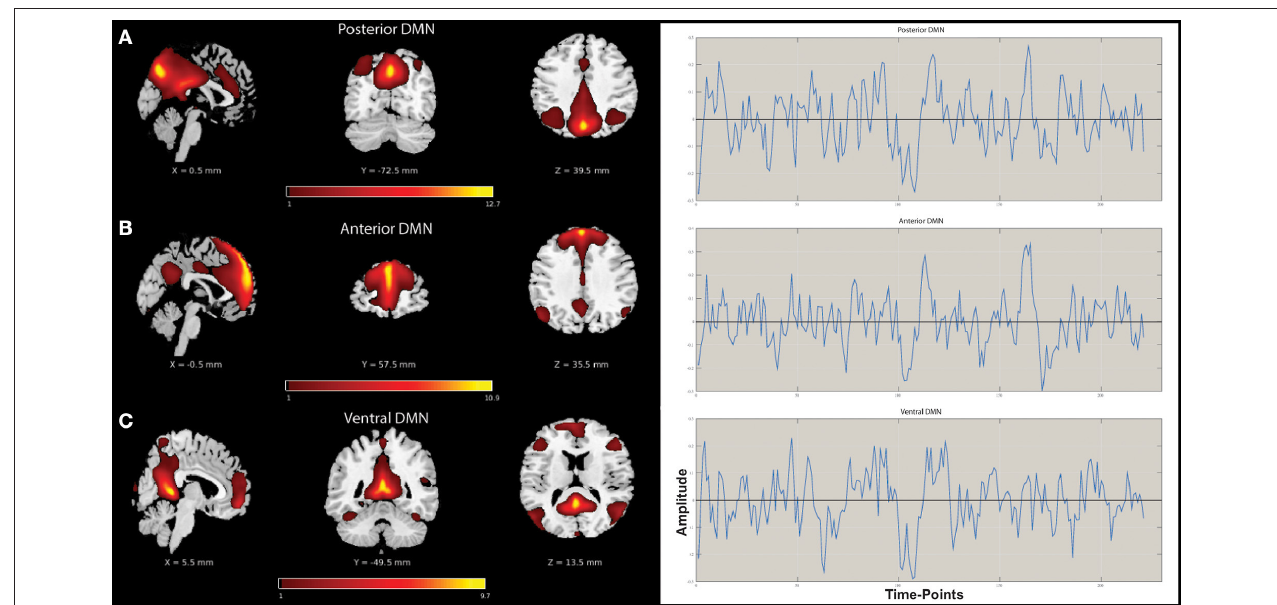
FIGURE 1 | Spatial distribution maps and associated time-courses of DMN subnetwork components. (A) Posterior DMN (pDMN), (B) Anterior DMN (aDMN), and (C) Ventral DMN (vDMN).